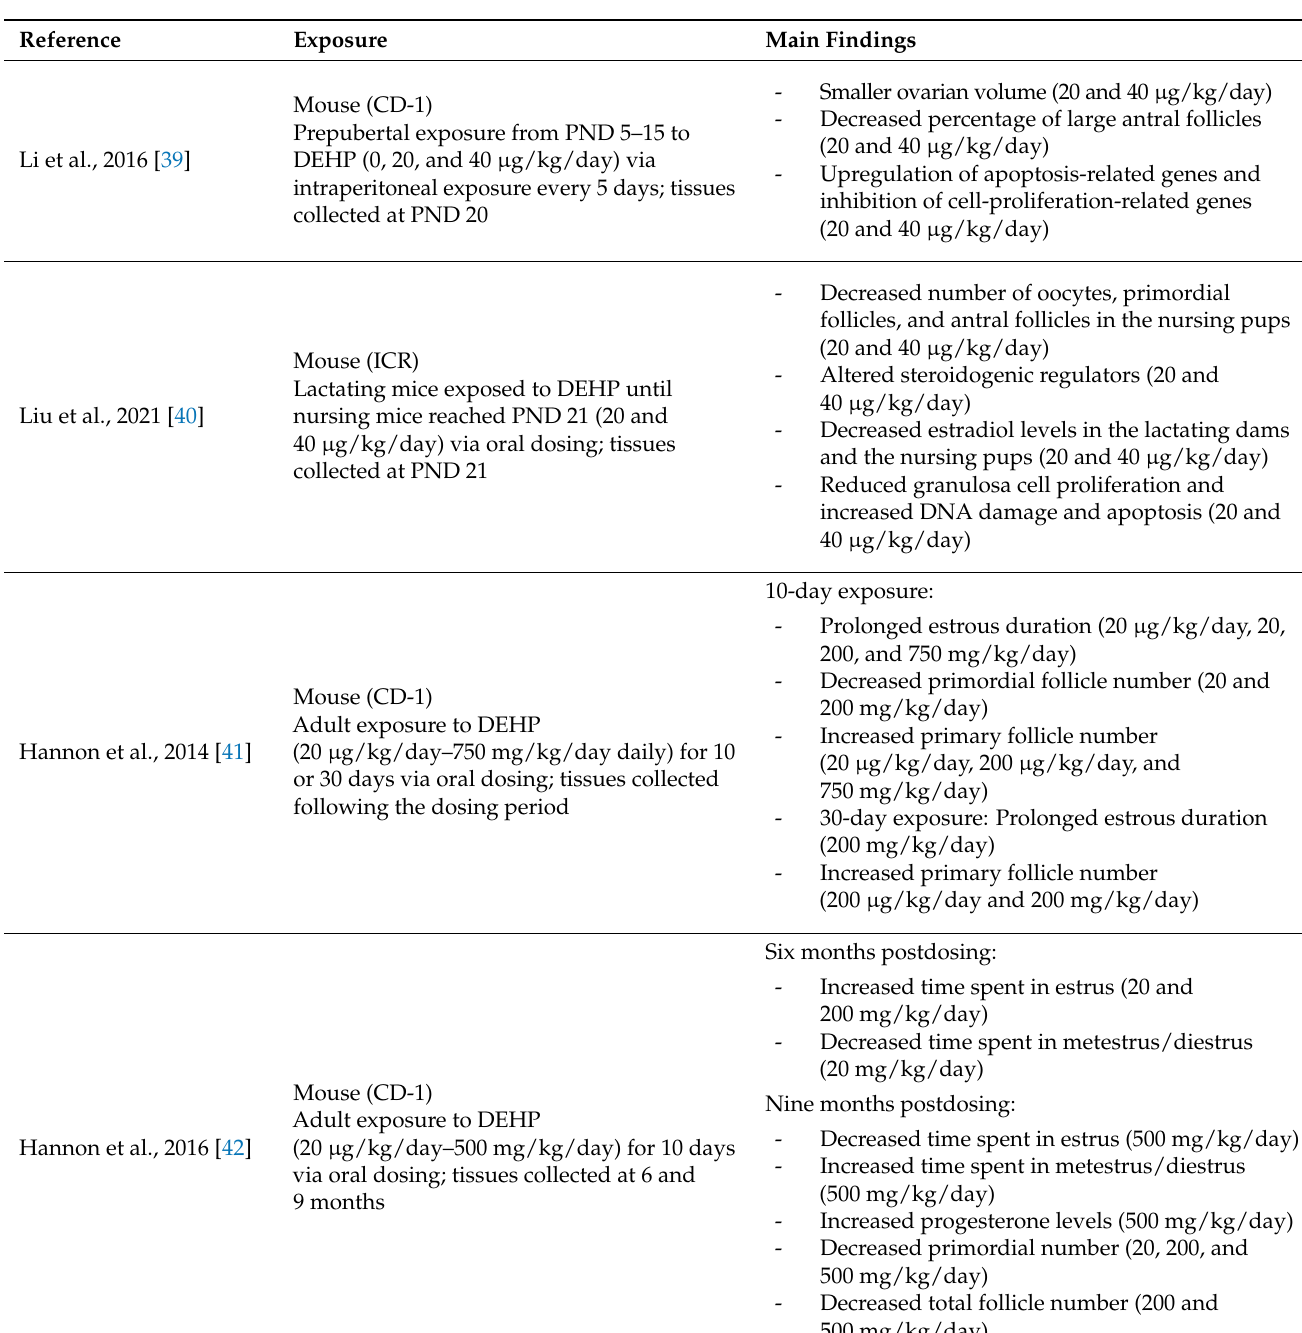
Table 1. Effects of single phthalates and phthalate mixtures on the ovary and female reproduction in